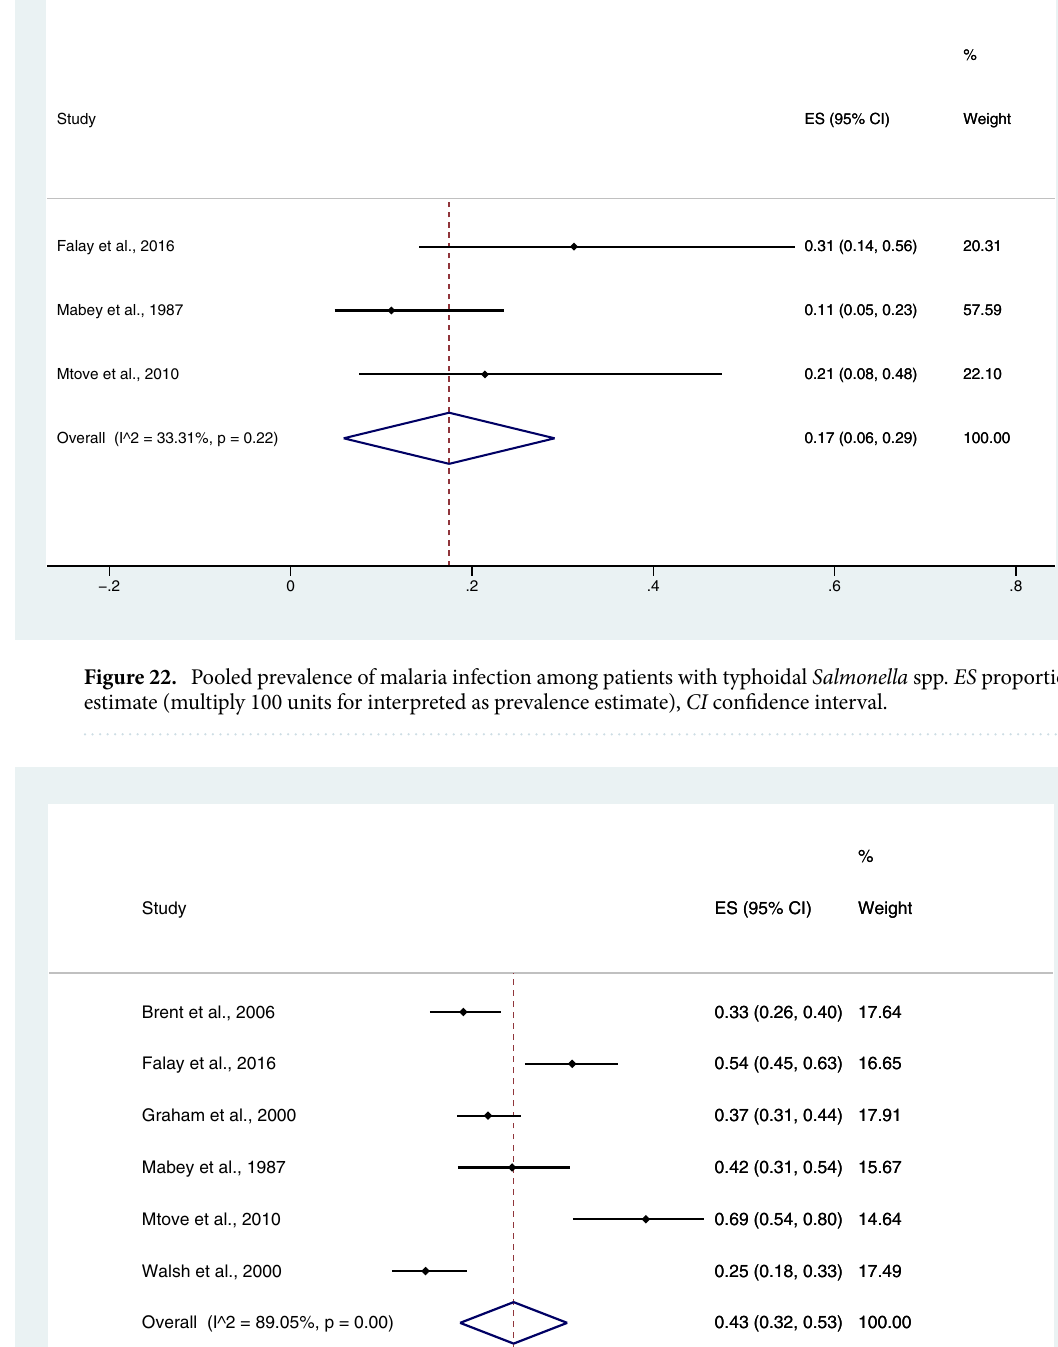
Overall (I^2 = 89.05%, p = 0.00)